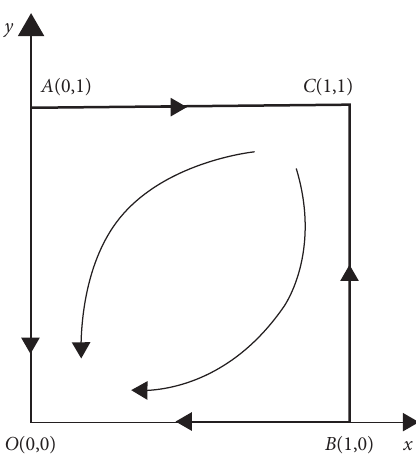
Figure 4: Dynamic evolution of the system in Scenario